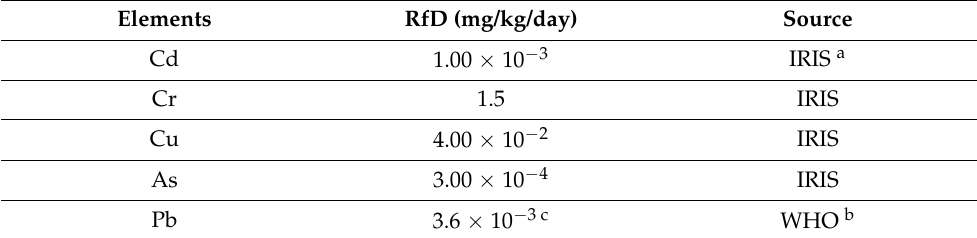
Table 1. Reference doses (RfD) of five heavy